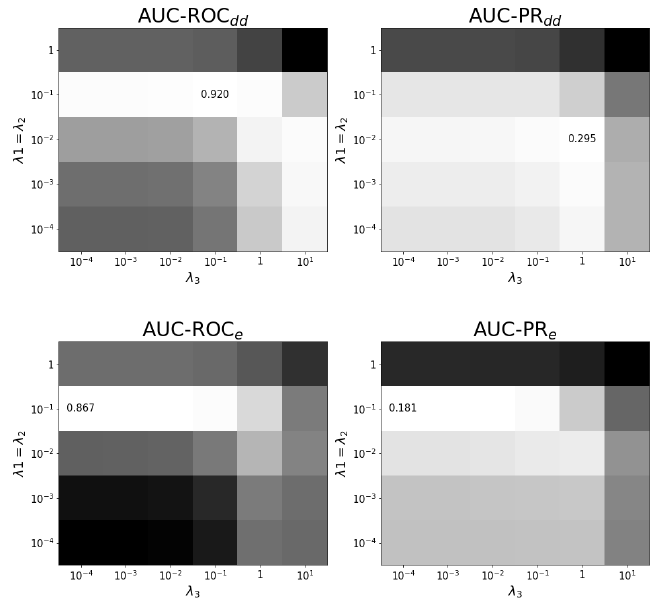
Figure A2. Tuning regularization parameters for task (cid:99) dde . The average performance on ten training folds using shortcuts for leave-out validation is shown for different combinations of regularization parameters. The optimal combination and values are shown. White corresponds to the highest performance and black to the lowest. Each panel has a different color scale as performance varies over different scales.